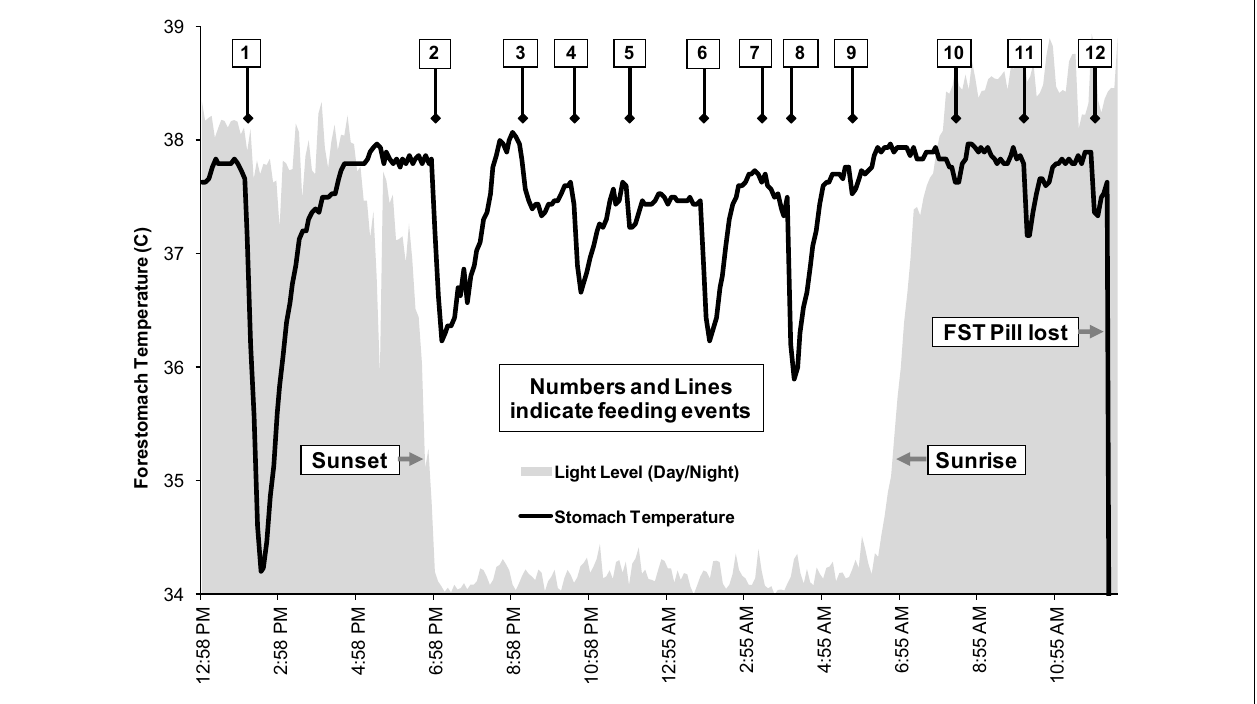
FIGURE 6 | Foraging record for dolphin F189 as indicated by changes in forestomach temperature .Twelve apparent feeding events are indicated by arrows, occurring throughout the day and night [from Ref.